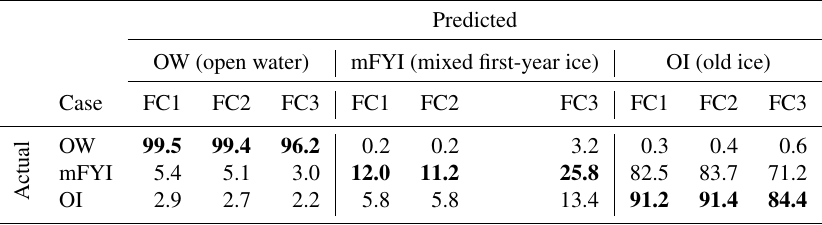
Table 7. Confusion matrix of the three-class RF classifier which was trained with the DS1 summer dataset and applied to the DS2 summer dataset. The bold font indicates where the classification was done correctly. Predicted